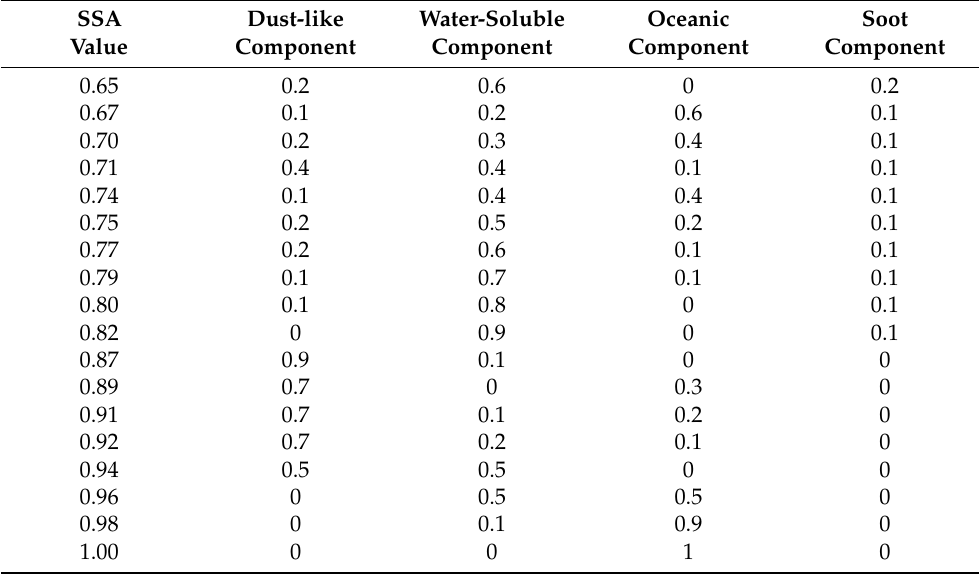
Table 3. List of percentage of each aerosol particle component in the simulation of